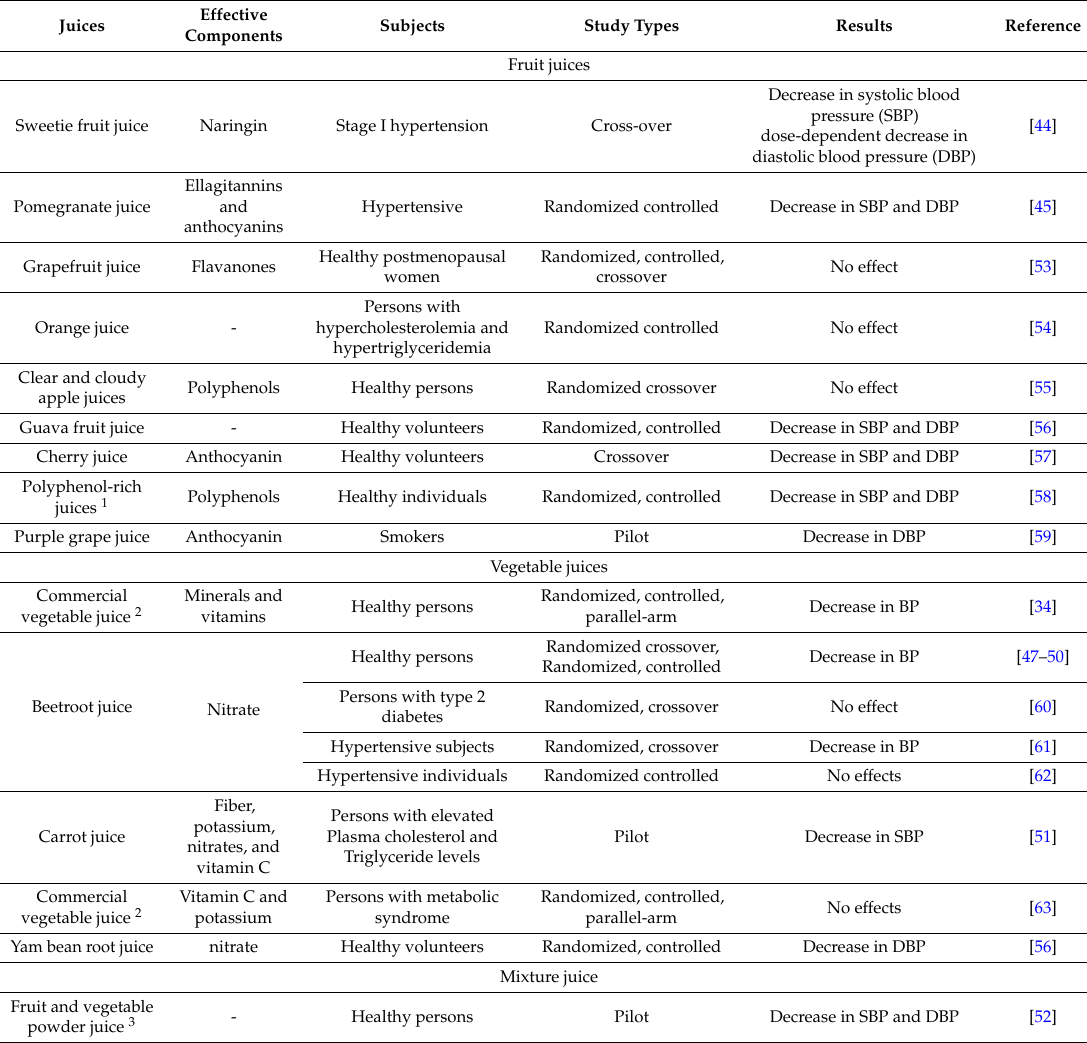
Table 1. Effects of juices on blood